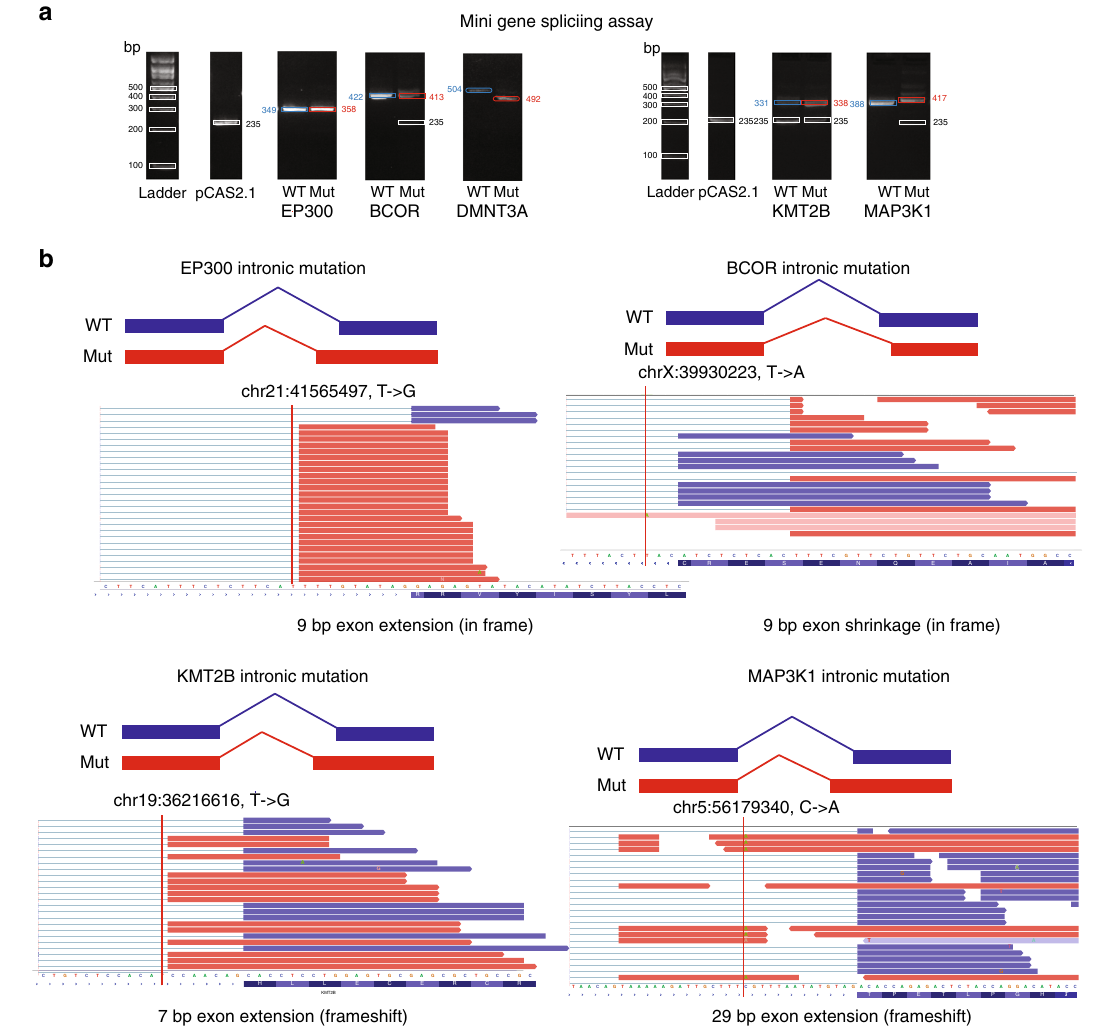
Fig. 6 Experimental validation of nc-SCMs by the mini-gene splicing assay. a Validation of non-coding splice-site-creating mutation candidates by the mini-gene splicing assay ( “ Methods ” ). All experiments were performed by three replicates and gave similar results (see Source Data fi le for the full scans). b Integrative Genomics Viewer (IGV) screenshot of four validated mutation-induced exon extension or shrinkage events. Red vertical lines indicate the mutation positions. Source data are provided as a Source Data fi